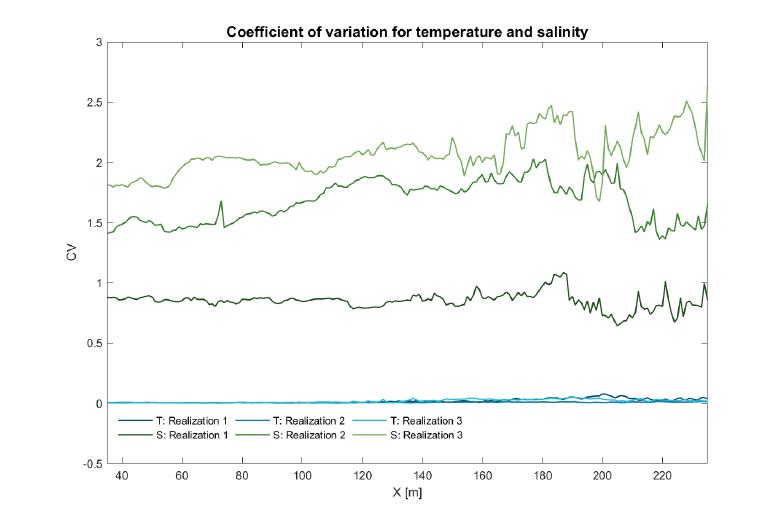
Figure 21. Coefficient of variation (CV) for temperature and salinity in the down stream